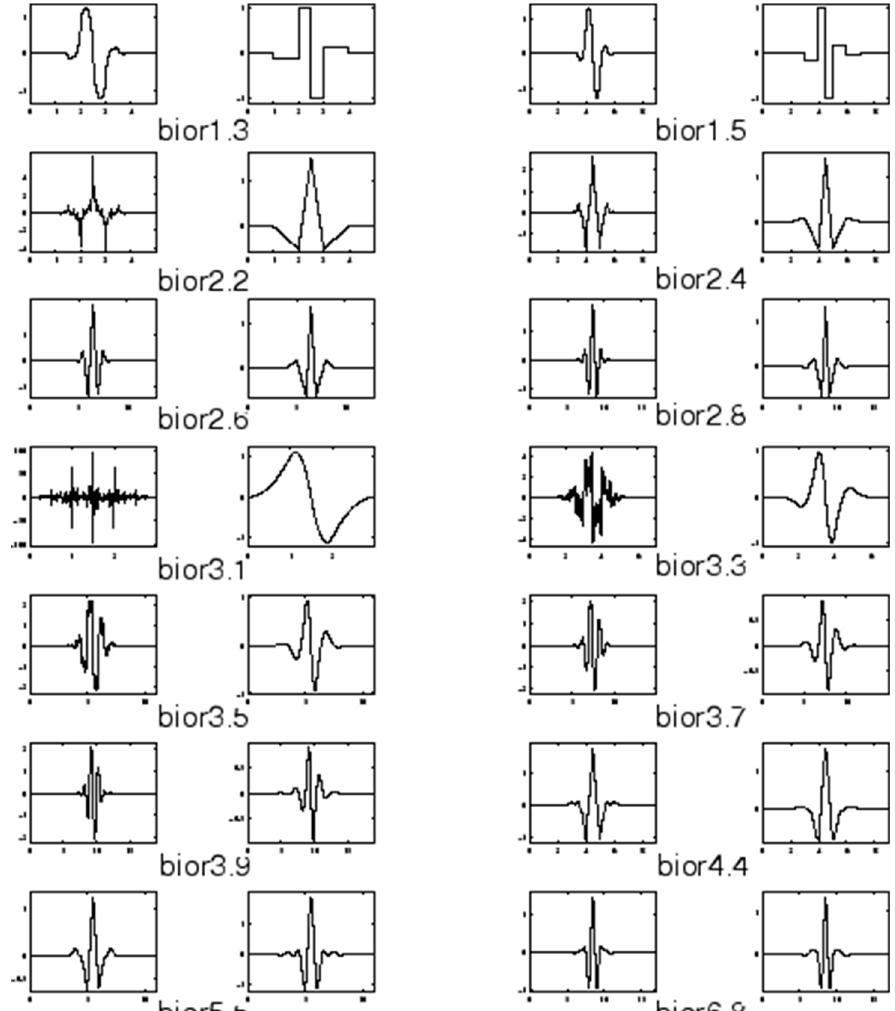
Figure 2. Showing the comparison of the decomposed signal of biorthogonal family.